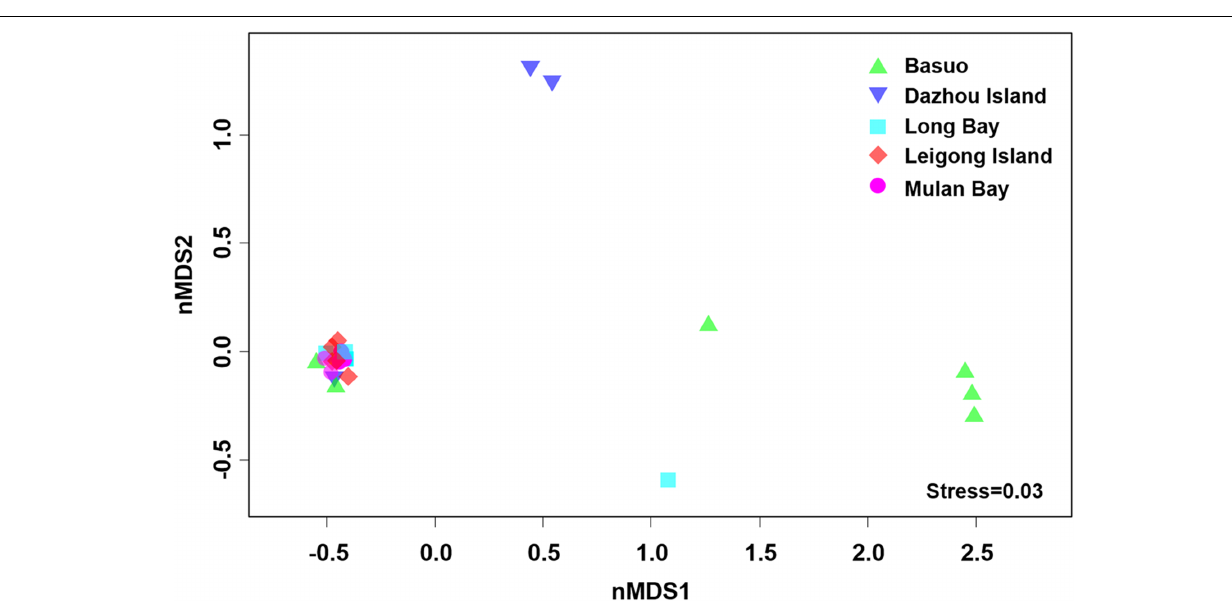
multiple Symbiodinium subclades belonging to different